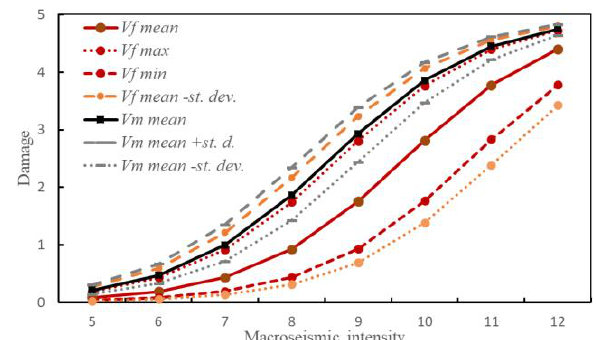
Figure 11. Comparison between the damage curves obtained for the aggregate studied both through the two different methodologies: the Giovinazzi and Lagomarsino macroseismic one (indicated with m ) and the Formisano’s one ( f index).